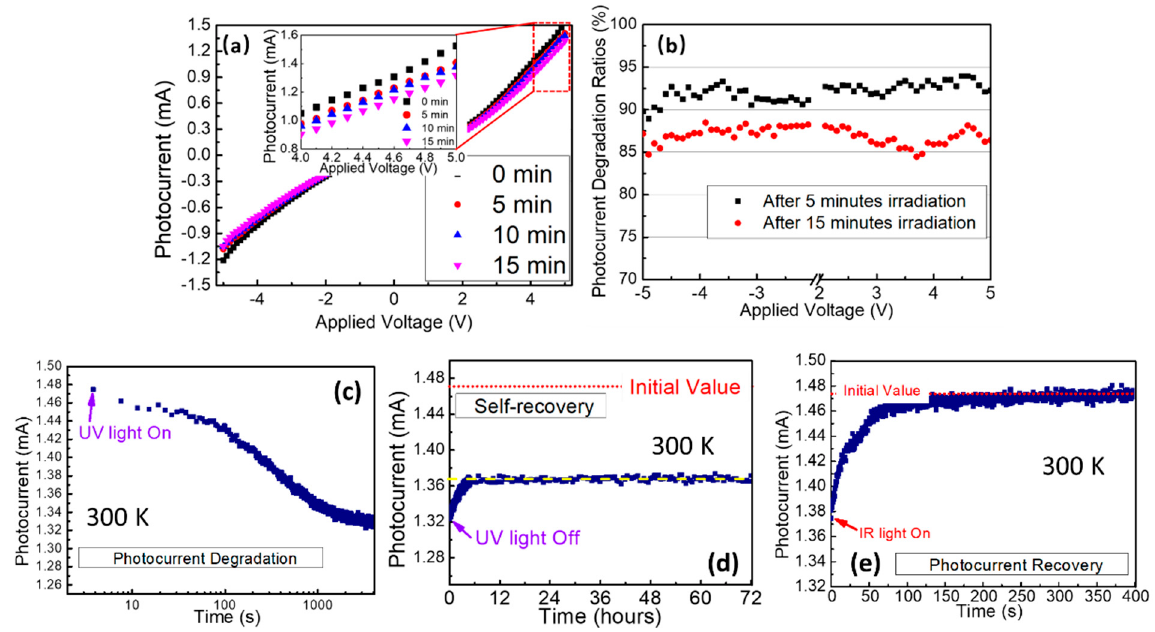
Figure 4. ( a ) Light-induced photocurrent degradation of the I–V response under different UV light exposure time (the inset is the enlarged photocurrent data in 4–5 V); ( b ) Light-induced photocurrent degradation rate versus applied bias voltage after 5– and 15–min irradiation; ( c ) Dynamics of the photocurrent intensity along with UV light exposure; ( d ) Dynamics of the self-recovered photocurrent intensity after UV light was turned off; ( e ) Dynamics of the recovered photocurrent intensity along with IR light exposure.